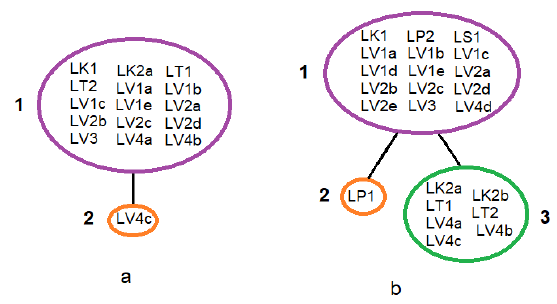
Figure 4. Haplotype network of Lupinus polyphyllus from different parts of its secondary distribution range: ( a ) Locus ITS; ( b ) Locus rpl32–trnL.